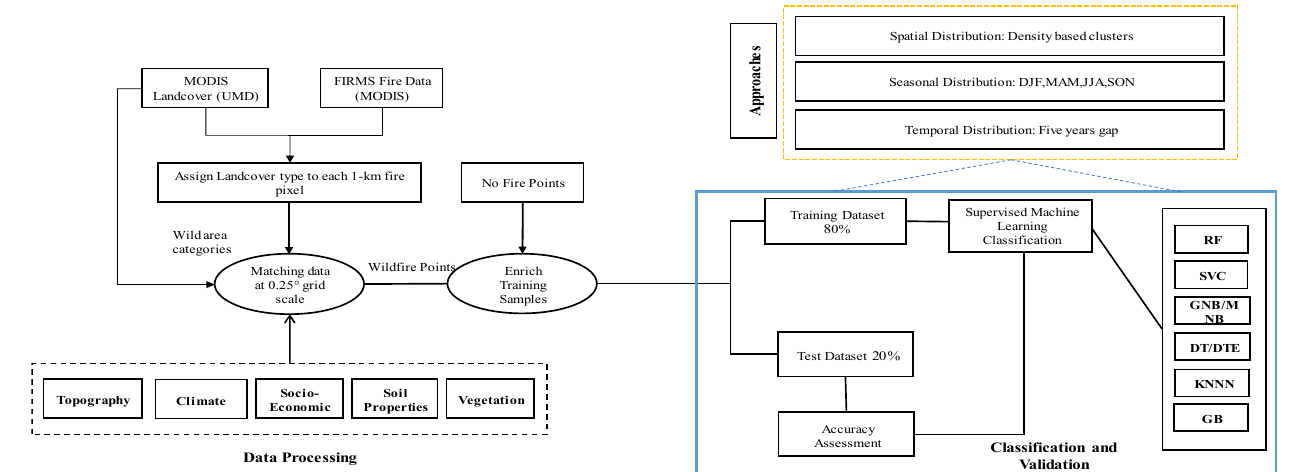
Figure 5. Flowchart of data processing and